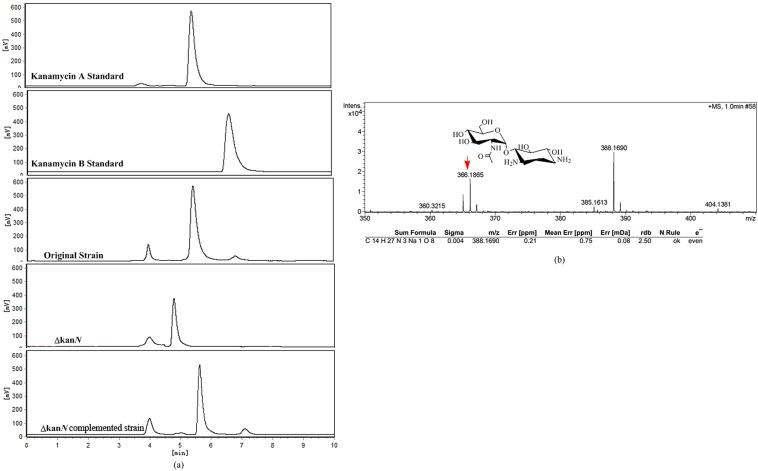
Metabolite analysis of S. kanamyceticus CG305 and S. kanamyceticus ΔkanN.(a) HPLC analysis of metabolites. (b) HPLC-MS analysis of the products of S. kanamyceticus ΔkanN.